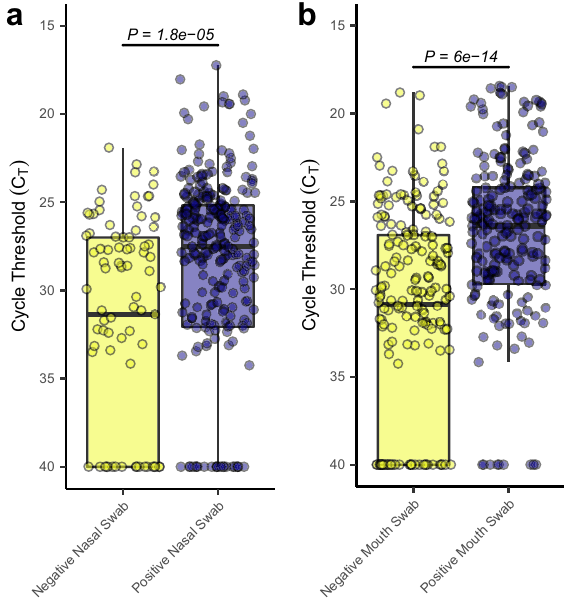
Figure 4. Potential intermittency of viral shedding and production. ( a ) Boxplots of the observed cycle threshold values for active air samples collected by the AerosolSense sampler from room entries when the study participant returned a negative shallow nasal swab (yellow) and a positive shallow nasal swab (purple). ( b ) Boxplots of the observed cycle threshold values for active air samples collected by the AerosolSense sampler from room entries when the study participant returned a negative oral swab (yellow) and a positive oral swab